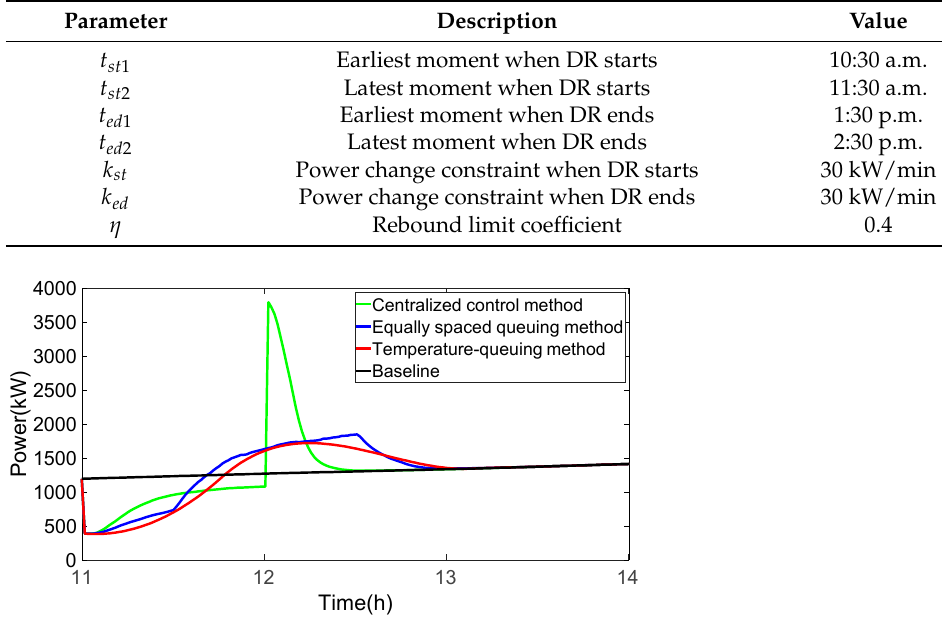
Figure 9. Total power of aggregated IAC load of different methods.